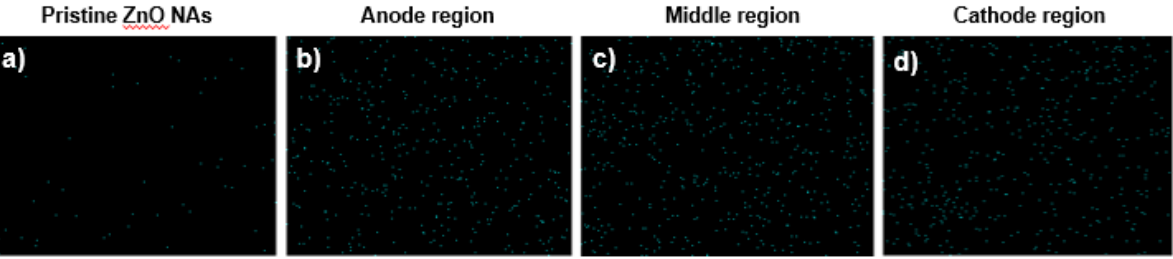
Figure S3: The EDX mapping images of nitrogen residual on different ZnO NA surfaces. (a) pristine ZnO NA. ZnO NAs grown at (b) anode regions, (c) middle regions and (d) cathode regions.